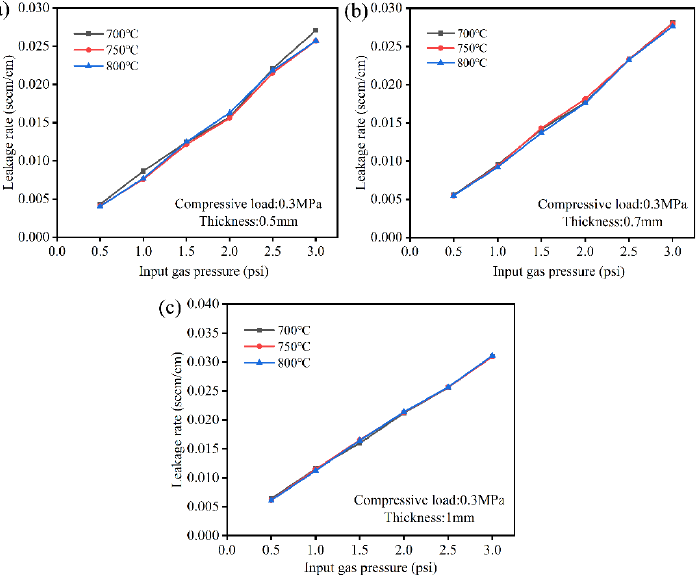
Figure 3. Effect of thickness and temperature corresponding to 0.5 mm ( a ), 0.7 mm ( b ), and 1 mm ( c ) on leakage rates under compressive load of 0.3 MPa.